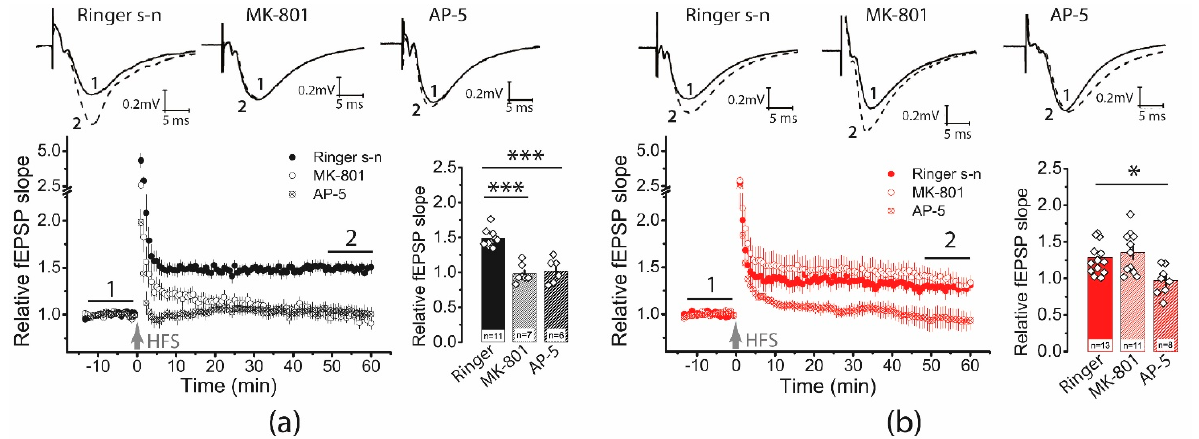
Figure 3. The NMDAR-dependent mechanism of LTP induction is weakened following PTZ-induced SE. On the left, diagrams show the normalized slope of fPSP in control ( a ) and post-SE ( b ) groups. On the right side of each panel are bar graphs (mean ± SEM) showing the effect of NMDAR inhibition with D-AP5 or MK-801 on LTP value in different groups. One-way ANOVA followed by Tukey’s post hoc tests: * p < 0.05, *** p < 0.001. Each rhombus represents a value